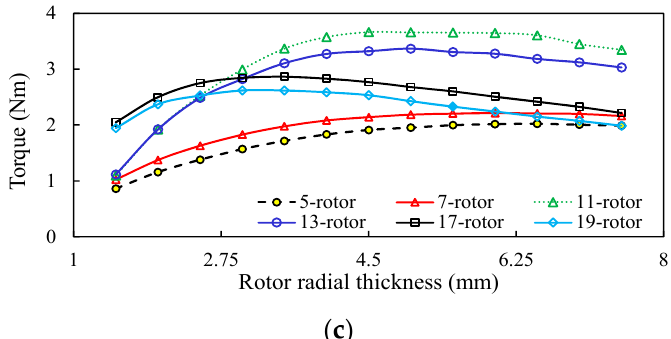
Figure 8. Variation of average torque with various rotor design parameters, I d = 0, copper loss = 30 W. ( a ) Inner rotor pole ratio; ( b ) Outer rotor pole ratio; ( c ) Rotor radial thickness.